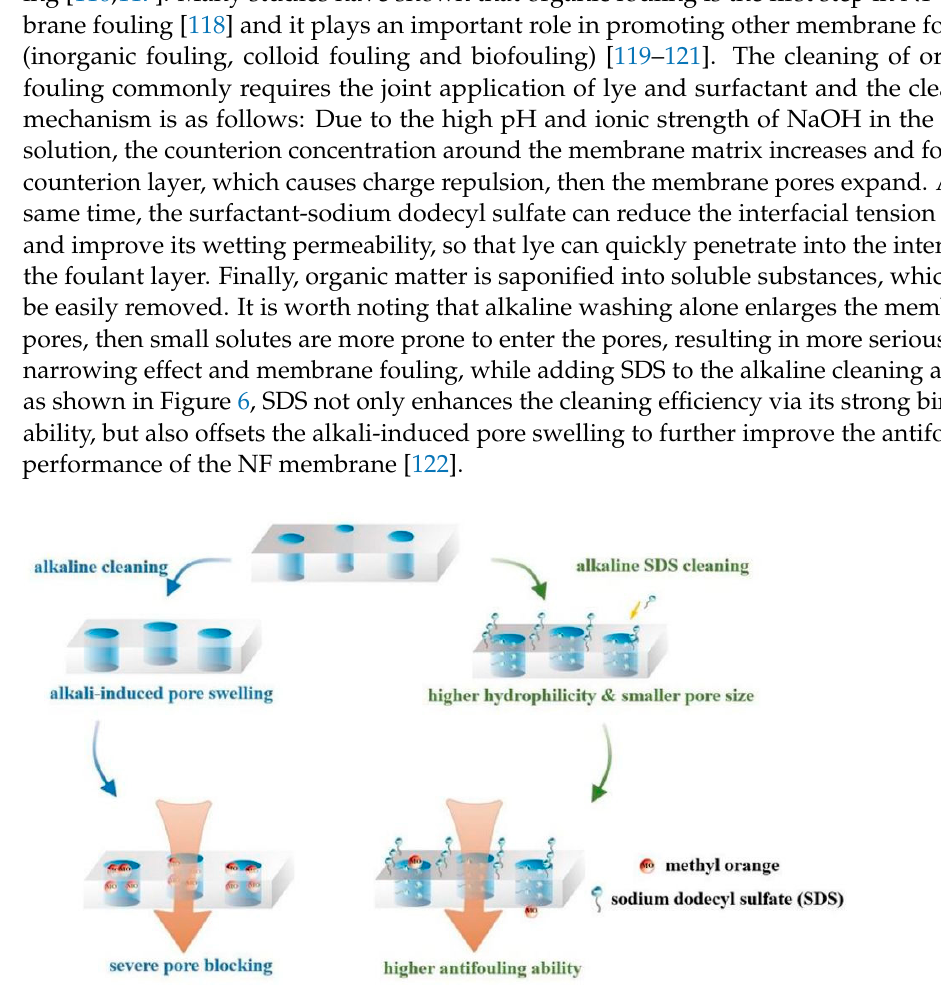
Figure 5. The classification of factors affecting chemical cleaning efficiency.